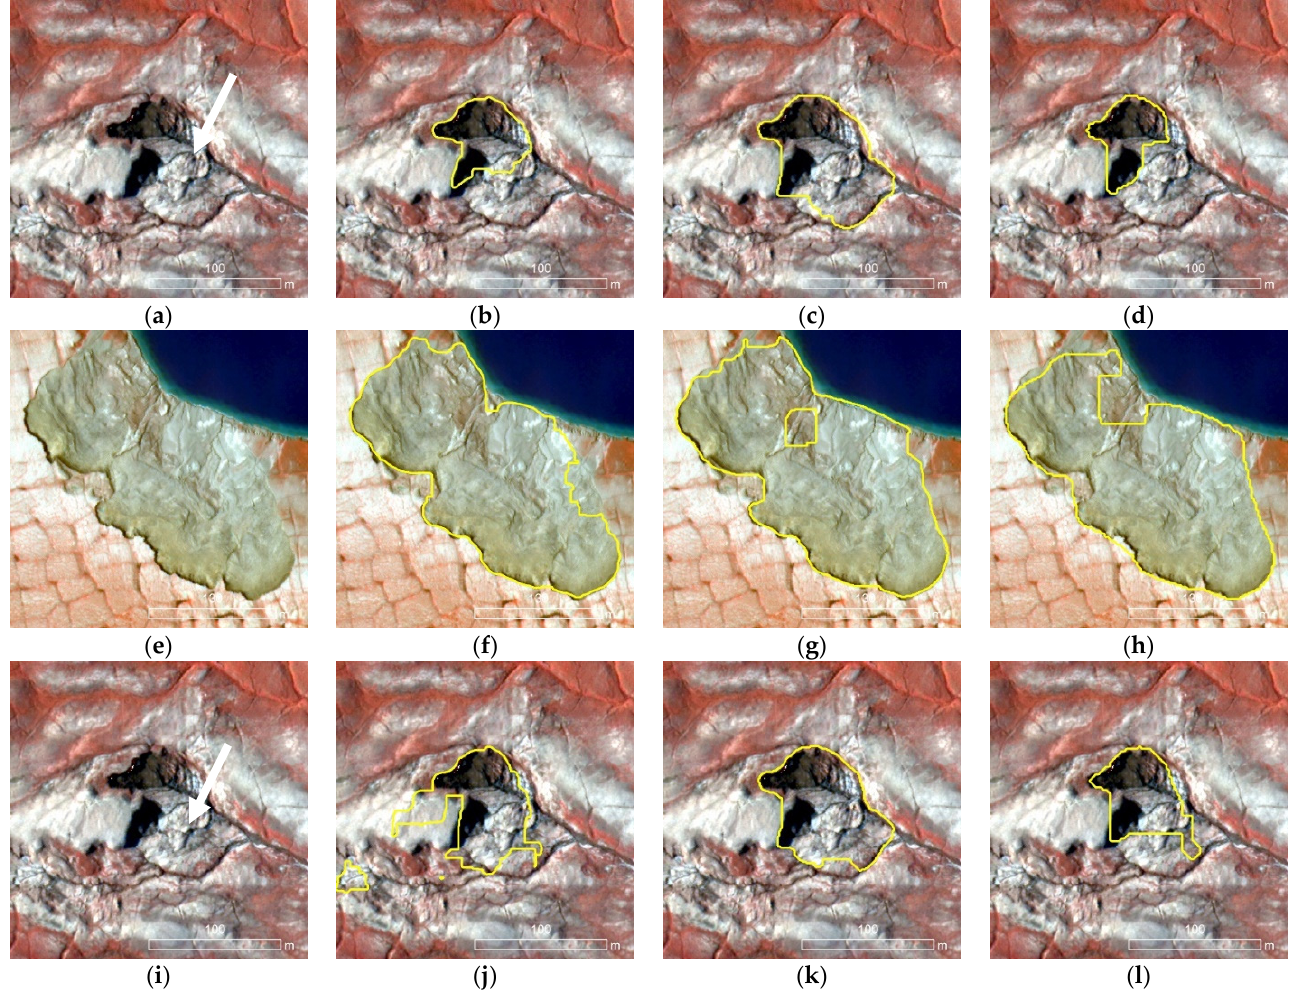
Figure 17. Example zoomed-in views of DLCNN model predictions on the test data from selected location of Banks Island and the Eureka Sound Lowlands. Examples exhibit training and prediction of input image tiles of 1024 × 1024 ( a , e , i ) without resizing 1024 × 1024 ( b , f , j ) and with resizing into two network input sizes: 512 × 512 ( c , g , k ), and 256 × 256 ( d , h , l ). Outline of the predicted RTS is shown in yellow outline. White arrows indicate the location of RTS. Underlying imagery is at 0.5 m resolution as false color composites.